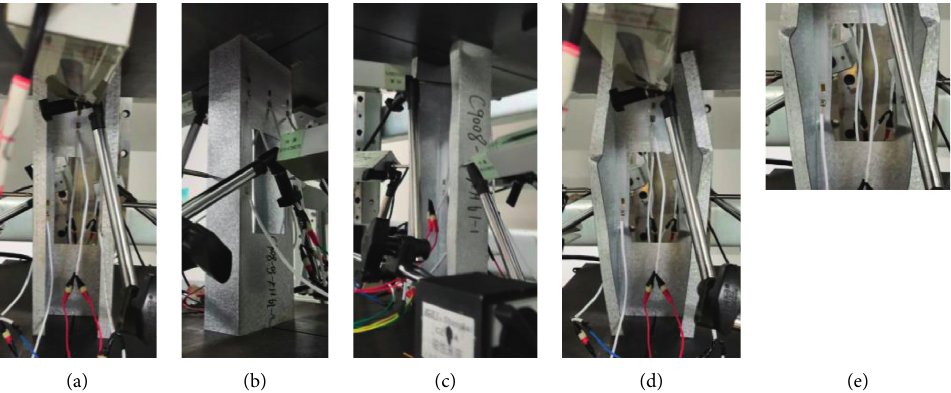
Figure 7: Buckling mode of specimen C9008-03-RH6-1. (a) Local buckling in the web. (b) Local buckling in the flange. (c) Local buckling in the lip. (d) Distortional buckling. (e) Local buckling of the plate strip adjacent to holes.